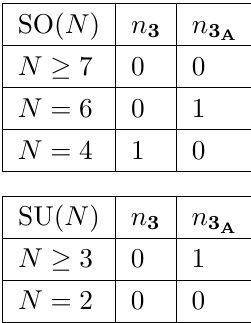
Table 2 . The counting of S 3 representations of non-quasi-invariant color structures. The results for SO( N ) with N = 5 , 3 are the same as those for N ≥ 8